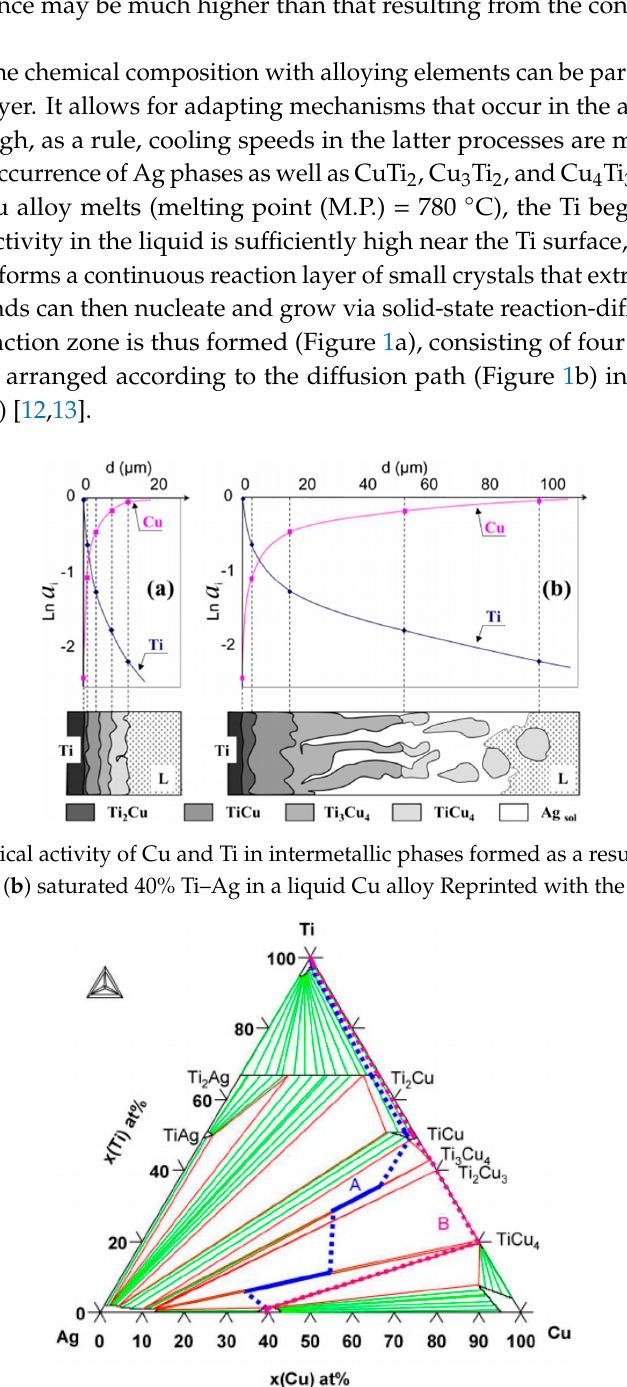
Figure 2. The Cu–Ag–Ti ternary phase diagram calculated at 790 ◦ C. Two di ff usion paths have been drawn corresponding to the reaction zones Reprinted with the permission of